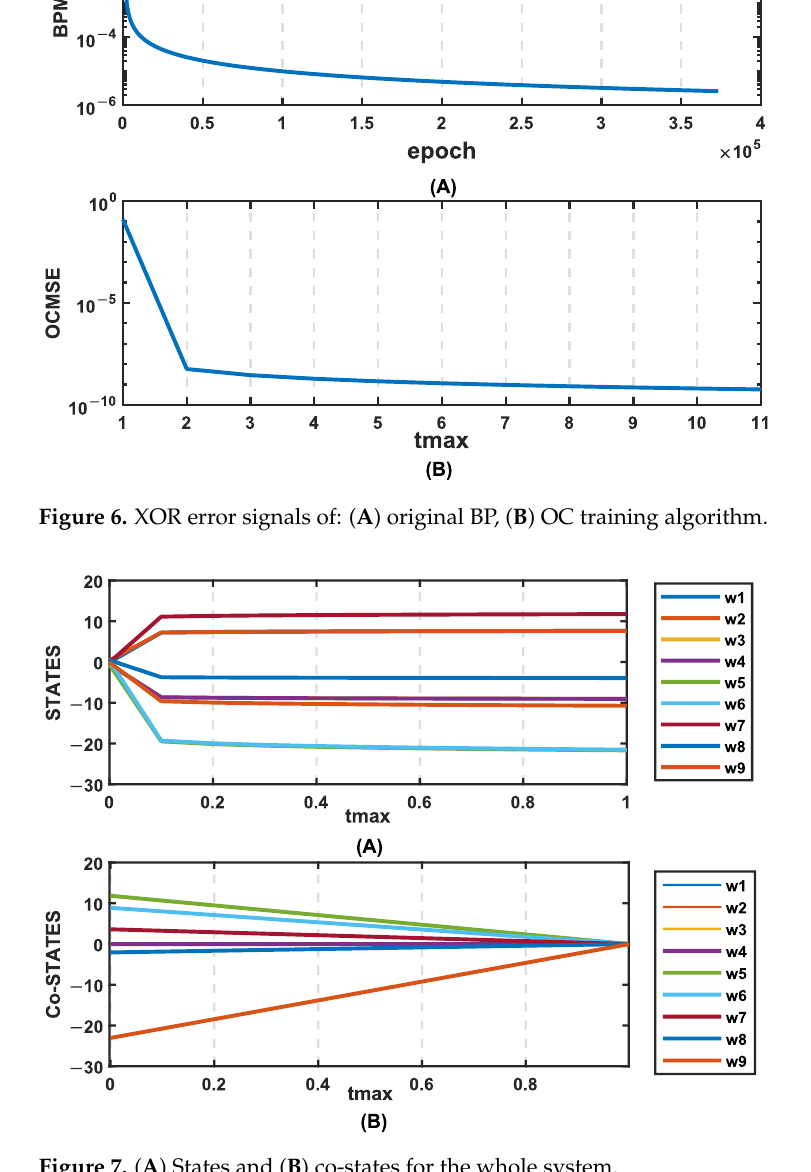
Figure 8. ( A ) Input control u with optimality condition ( B ) dH/du . Table 2. Comparison results of two training algorithms with different models. Training Models